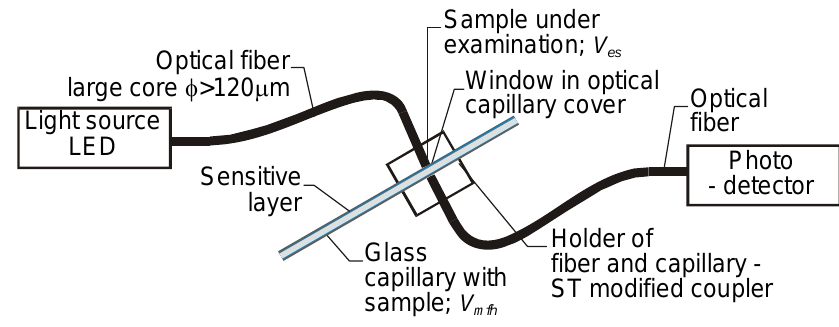
Figure 6. Optical capillary sensor with optical fibers for absorption measurements intended for monitoring transfluent